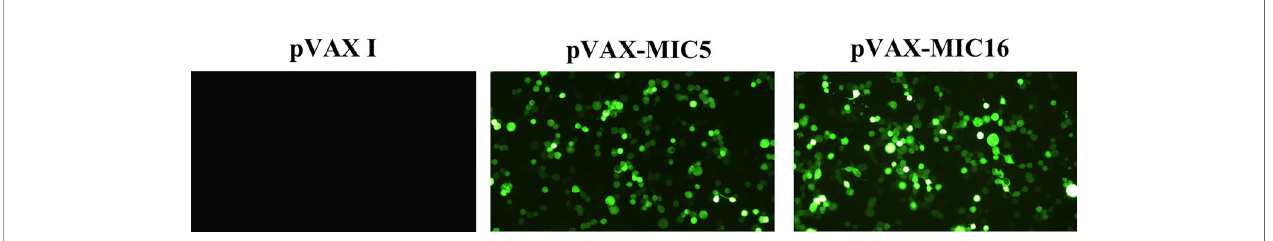
FIGURE 1 | Detection of the recombinant TgMIC5 and TgMIC16 protein expressed in 293T cells. 293T cells were transfected with empty pVAX I, pVAX-MIC5, or